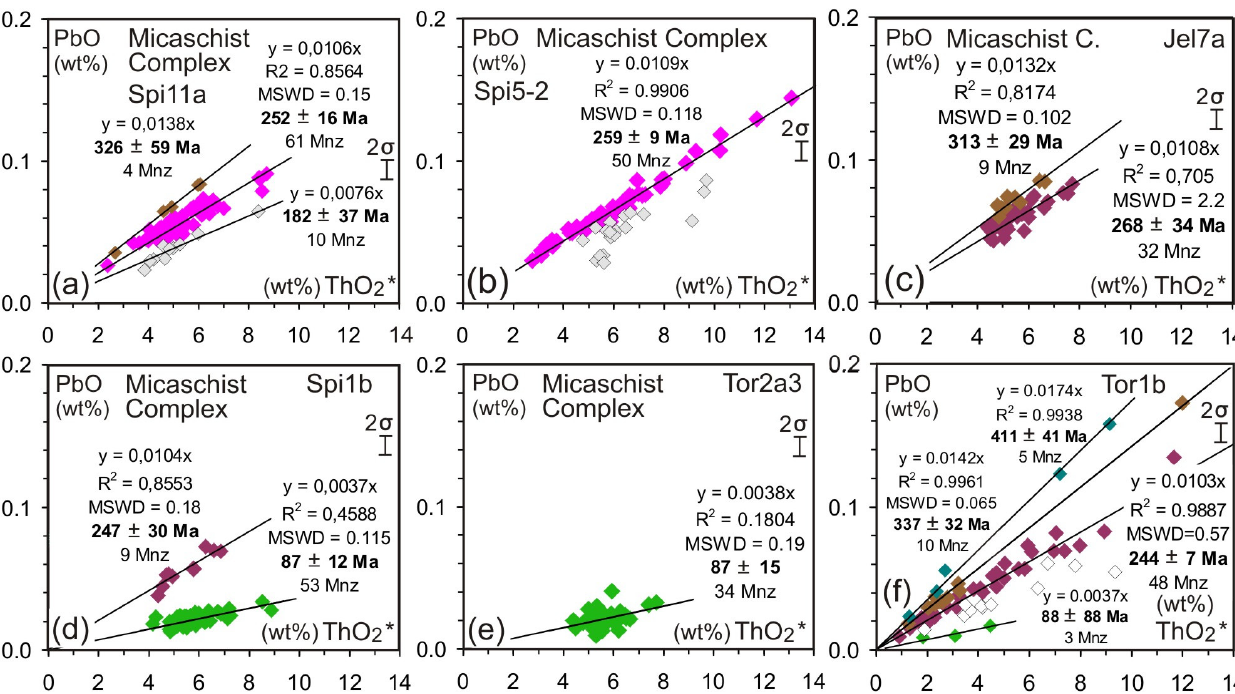
Figure 7. ( a – f ) Th-U-Pb chemical model ages of monazite in the Micaschist Complex of the Saualpe nappe stack. Total ThO 2 *-PbO (wt%) isochrone diagrams. ThO 2 * is ThO 2 + UO 2 equivalents expressed as ThO 2 . General minimal 2 σ error on monazite PbO analysis is shown by a bar. Regression lines of monazite populations marked by colours give a coefficient of determination R 2 and were forced through zero. The coloured symbols mark analyses belonging to monazite age populations and defining isochrones, falling into Silurian (bluegreen), Carboniferous (brown), Permian (violet) and Cretaceous (green) ranges of ages; further Mesozoic monazite data are in white.